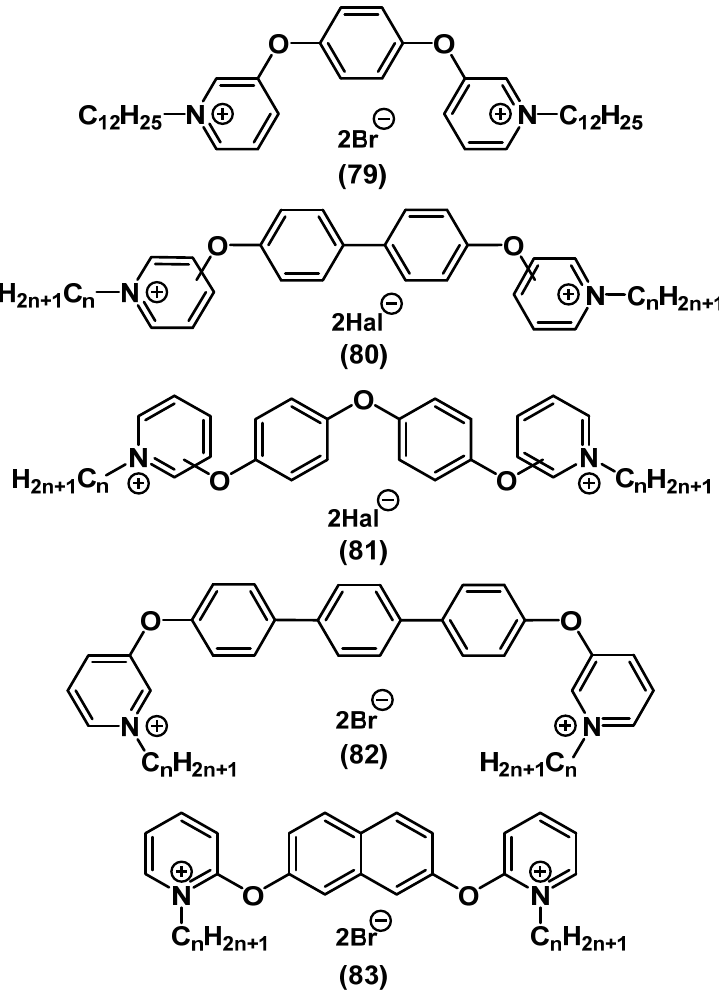
Figure 27. Pyridine-based bis-QACs containing aromatic spacers. There is a broad variety of structures of bispyridinium salts containing mixed spacers (Figure 28).